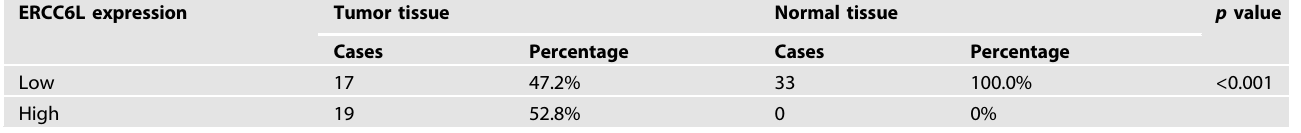
Table 1. Expression patterns in laryngocarcinoma tissues and normal tissues was revealed by immunohistochemistry analysis.